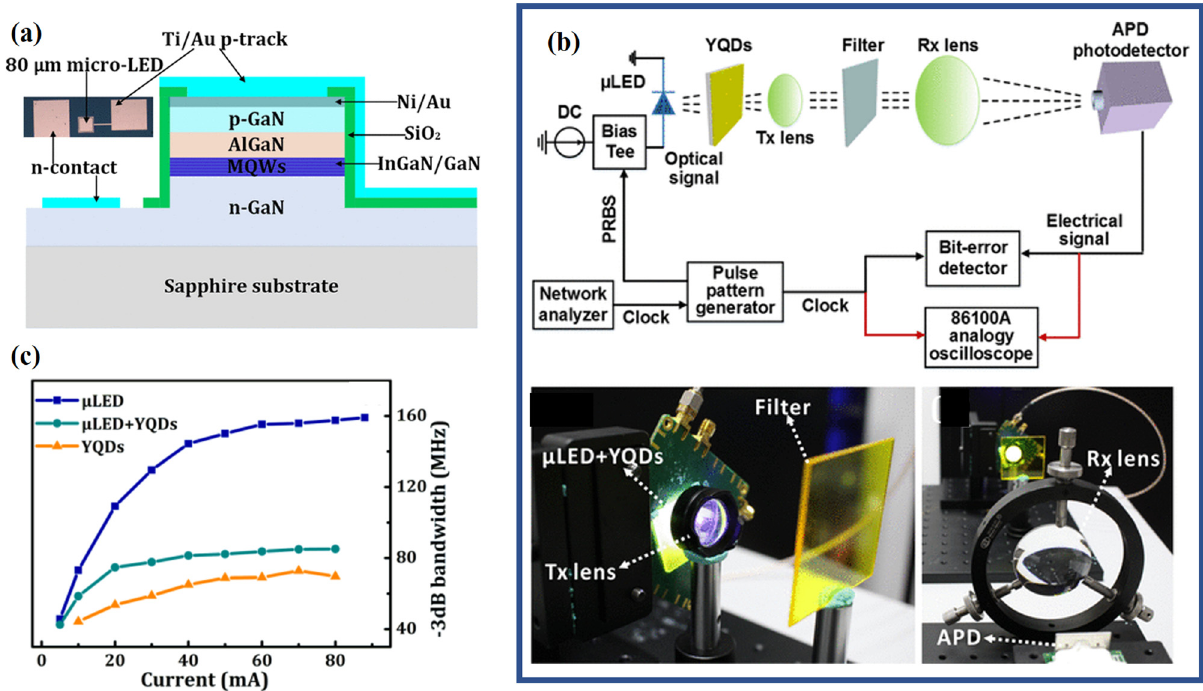
Figure 11: ( a ) 2D structure diagram of the fabricated μ LED. ( b ) VLC link diagram and experimental device. ( c ) Comparison of - 3 dB modulation bandwidth between μ LED, μ LED + YQDs system, and YQDs. Reproduced with permission from ref. [ 120 ] . Copyright 2018, American Chemical